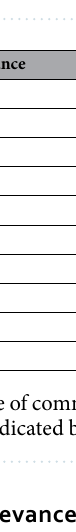
Table 1. Relevance of community pairs in the RC network. Pairs represent the community pairs in the network and are indicated by their IDs.